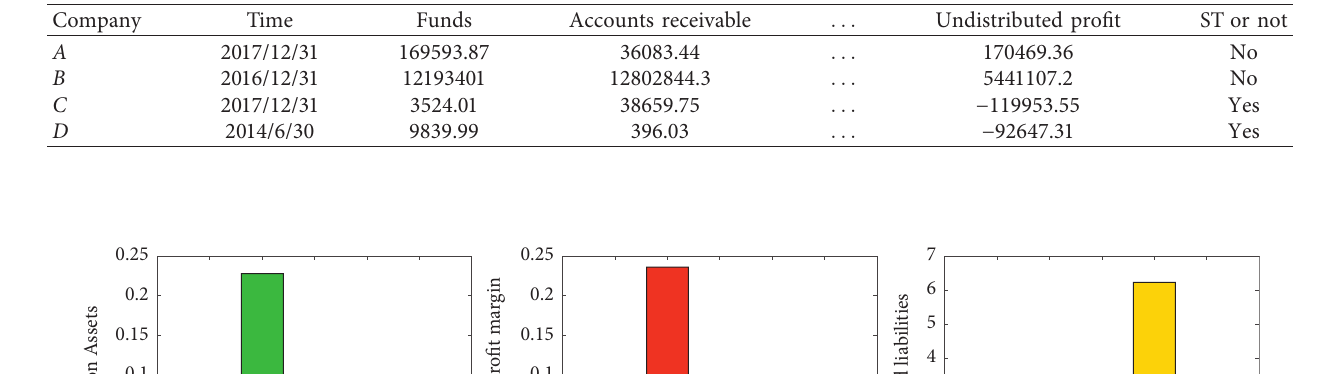
Table 1: The financial risk of the enterprise.